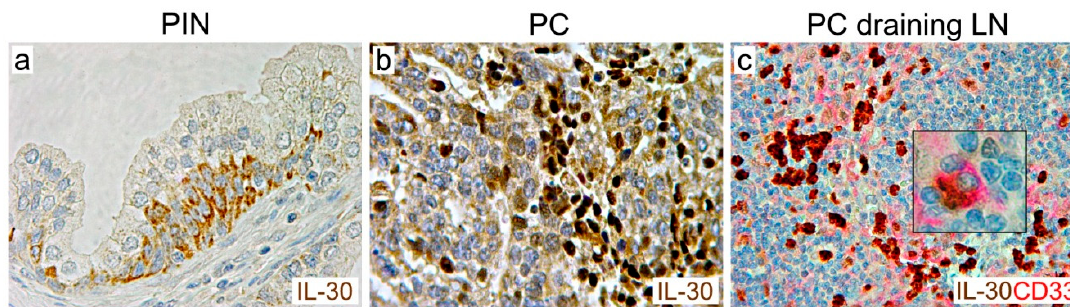
Figure 2. Expression of IL-30 in prostatic intraepithelial neoplasia, high-grade prostate cancer and myeloid cells of a cancer draining-lymph node. Immunohistochemistry reveals the expression of IL-30 (in brown; ab118910, Abcam) in basal stem-like cells of prostatic intraepithelial neoplasia (PIN) ( a ), in both cancer cells (faint) and leukocytes (strong) that infiltrate high grade (Gleason 8: 4 + 4) prostate cancer (PC) ( b ), and in most of the myeloid cells (in red; anti-CD33 antibody, clone PWS44; Leica Biosystems) in the lymph node that drains this tumor ( c ), as better shown by the inset. (Magnification: a, b: ×630; c: ×400; inset in c: ×1000).